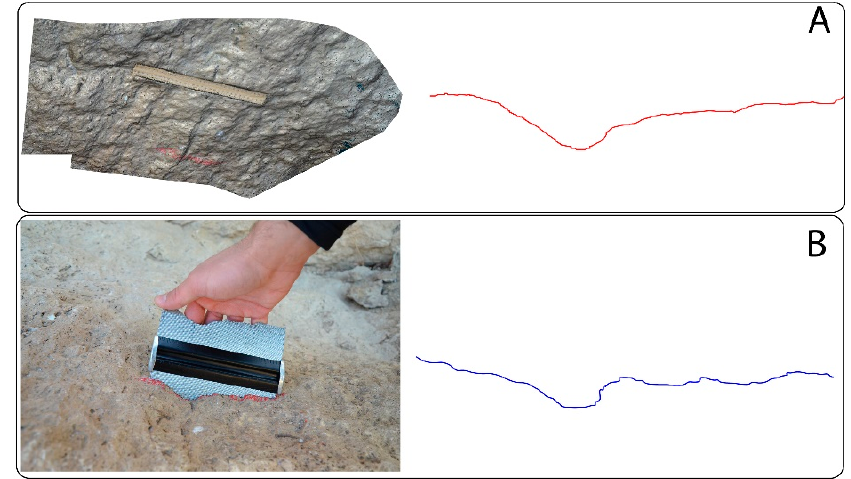
Figure 17. Joint roughness extracted from a high-resolution DP model ( A ) and joint-profiling comb ( B ).